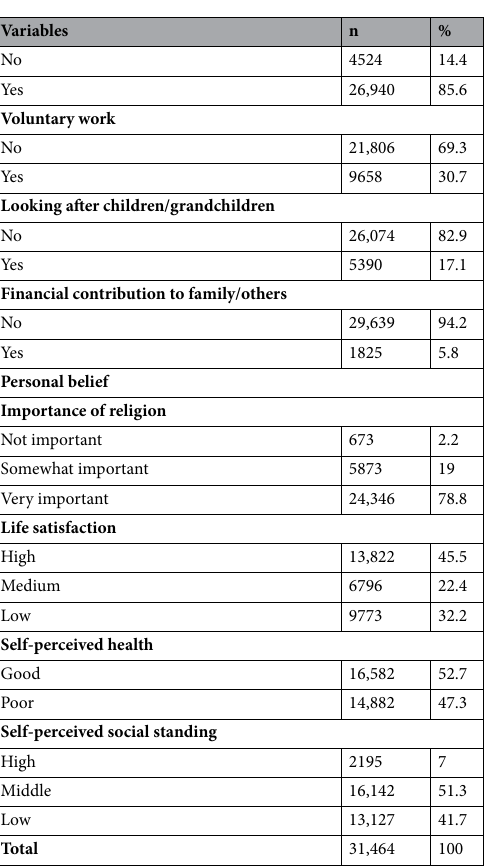
Table 1. Socio-economic profile of older adults in India, 2017–18. sd: Standard